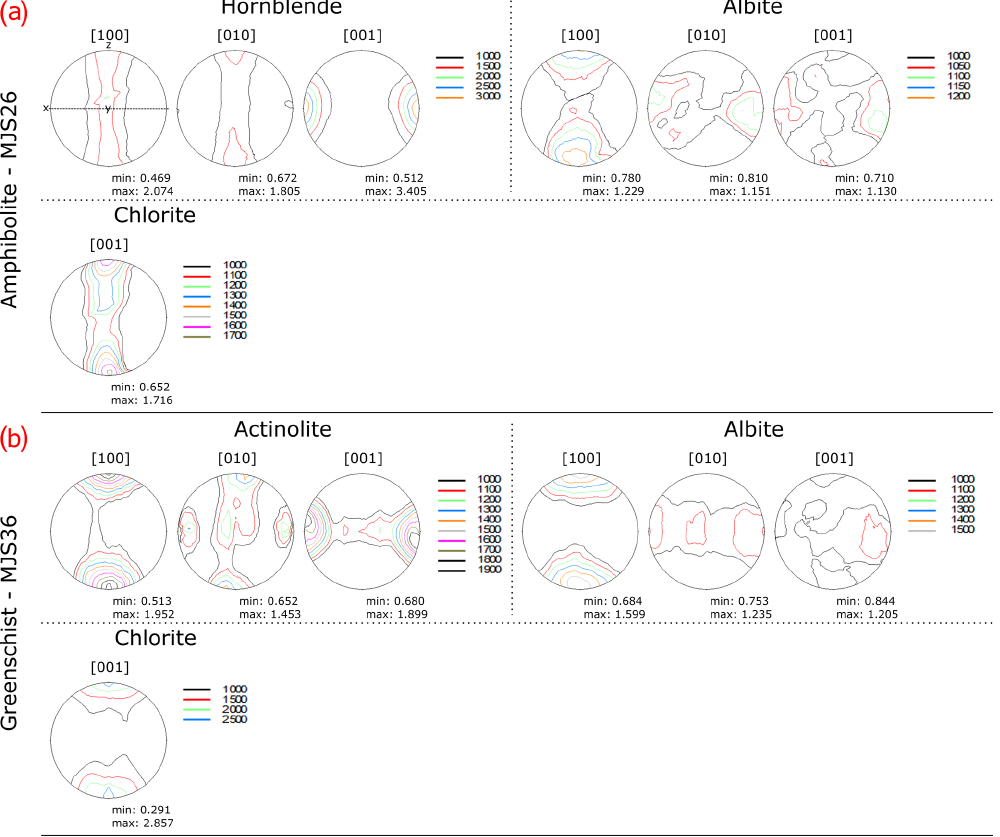
Figure 5. Calculated pole figures of important mineral phases in the amphibolite ( a ; MJS26) and the greenschist ( b ; MJS36). The stretching lineation (kinematic x direction) is oriented EW in the pole figures, the foliation normal (kinematic z direction) is oriented NS and the kinematic y direction (perpendicular to x and z directions) is normal to the pole figure plane. The pole figures are lower hemisphere equal area projections. The contour levels display multiples of random distribution and minimum and maximum values are listed below the pole